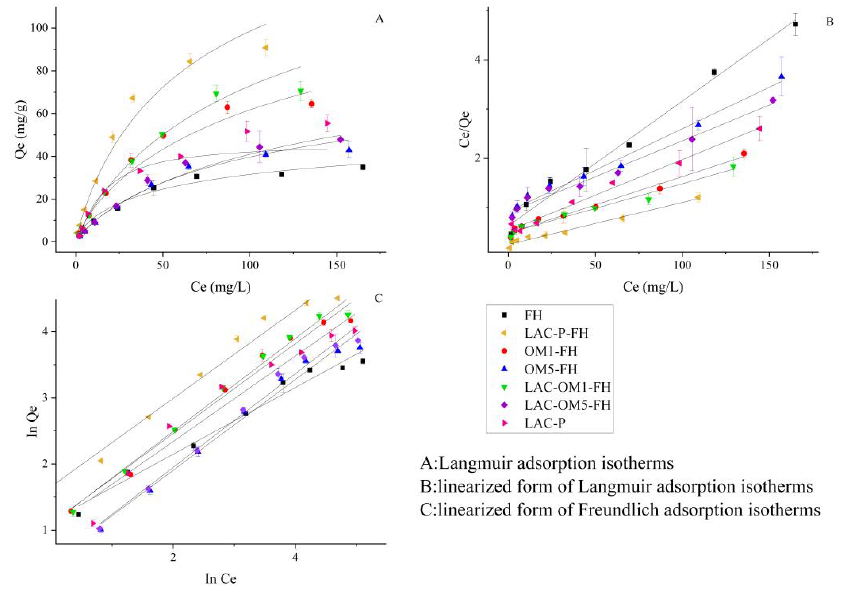
Figure 6. Equilibrium isotherm model analyses with the Freundlich and Langumuir models. Table 1. Fitting data of adsorption kinetics and isotherms adsorption of Cd onto FH and Fe-OM